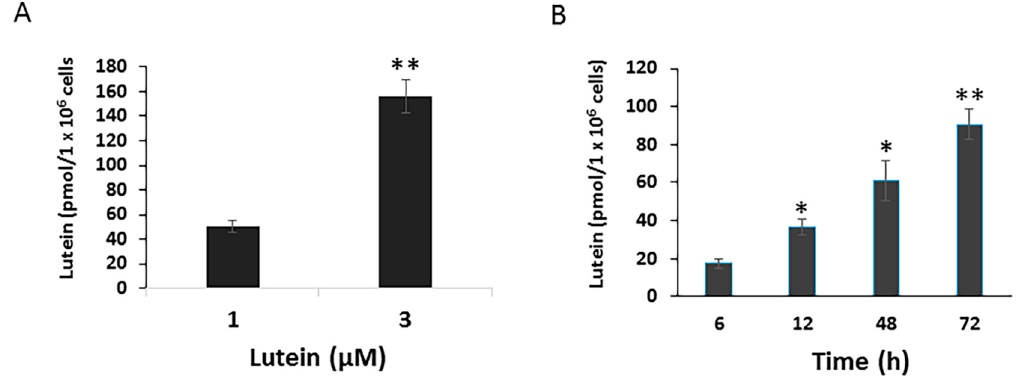
Figure 1. Dose and time-dependent cellular uptake of lutein in ARPE-19 cells. Cells were plated on six-well plates to reach confluence and then incubated with lutein at 1 or 3 µ M for 24 h. After incubation, cells were analyzed for their carotenoid content by HPLC analysis. Values are expressed as picomoles of carotenoid per million of cells ( A ) Data are shown as means ± SD of three independent experiments. ** : p < 0.001 compared with lutein at a given concentration. ( B ) Time course of lutein uptake in ARPE-19 cells. Cells were incubated with lutein at 1 µ M for varying times (6 h up to 72 h). After incubation, cells were analyzed for their lutein content by HPLC analysis. Data are shown as means ± SD of two independent experiments, * : p < 0.05, ** : p < 0.001.